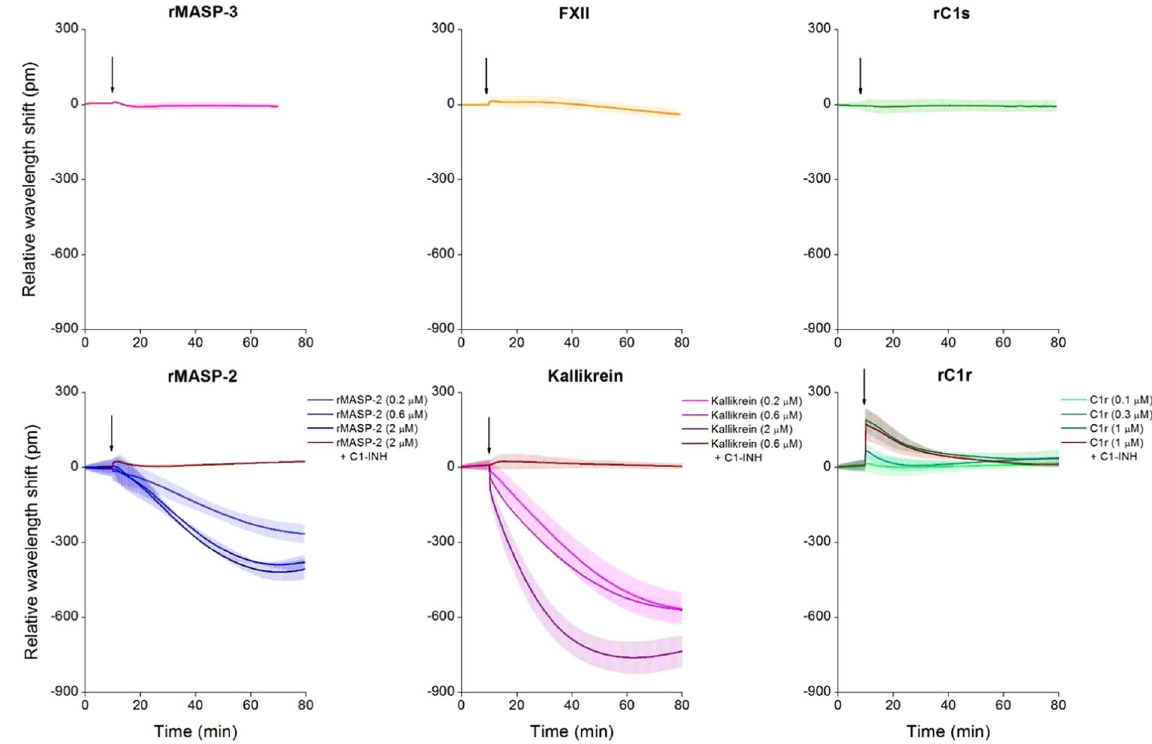
Figure 6. Effects of plasma serine proteases on the dynamic mass redistribution of confluent endothelial monolayers. A 384 well biosensor microplate was precoated with 0.2 mg/ml gelatin (37 °C, 20 min, PBS), then the wells were washed with PBS, and confluent monolayers of HUVECs were grown on the surface (24 h). The microplate was placed into the Epic BT reader, and after the stabilization of the baseline, serine proteases rMASP-3 (1 μ M), FXII (2 μ M), rC1s (1 μ M), rMASP-2 (0.2, 0.6 or 2 μ M) and kallikrein (0.2, 0.6 or 2 μ M), rC1r (0.1, 0.3 or 1 μ M) or culture medium alone was added. Proteases rMASP-2, kallikrein and rC1r were also applied in complex with their inhibitor, C1-INH (using a three-fold molar excess of C1-INH). Cell treatments were added directly to the culture medium, and the wavelength shift was monitored for 60 min. Wavelength shift curves were normalized to the medium control. The figures show representative graphs of at least 3 independent